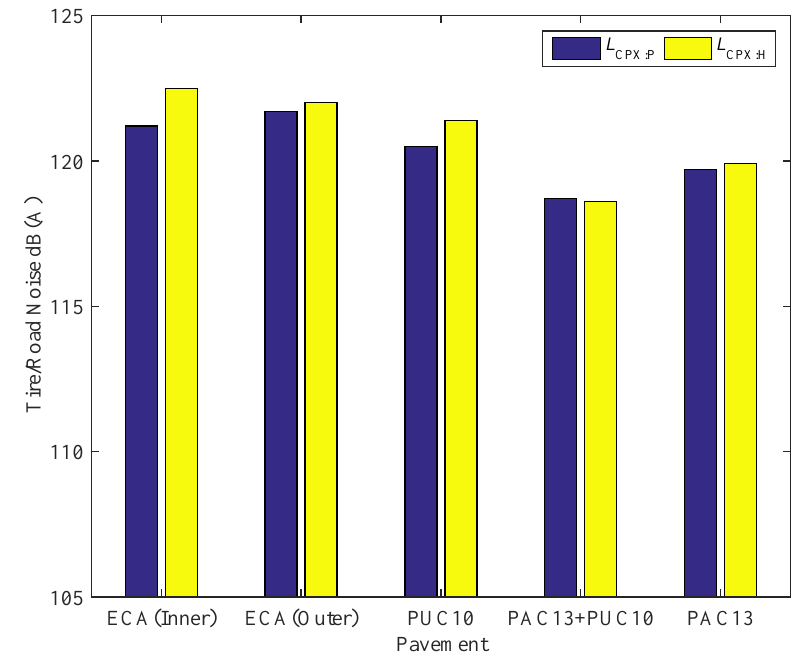
Figure 9. Tire/road noise for different pavements at 100